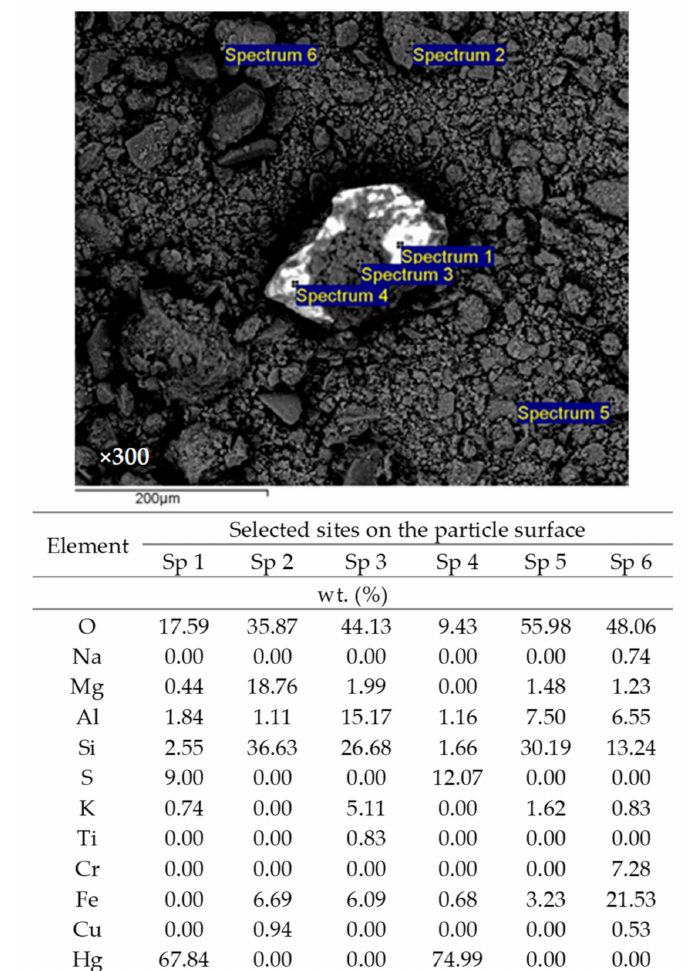
Figure 3. SEM image of mercury-contaminated soil particle magnified 300 × with six selected sites (spectra, Sp) analyzed, with corresponding EDS